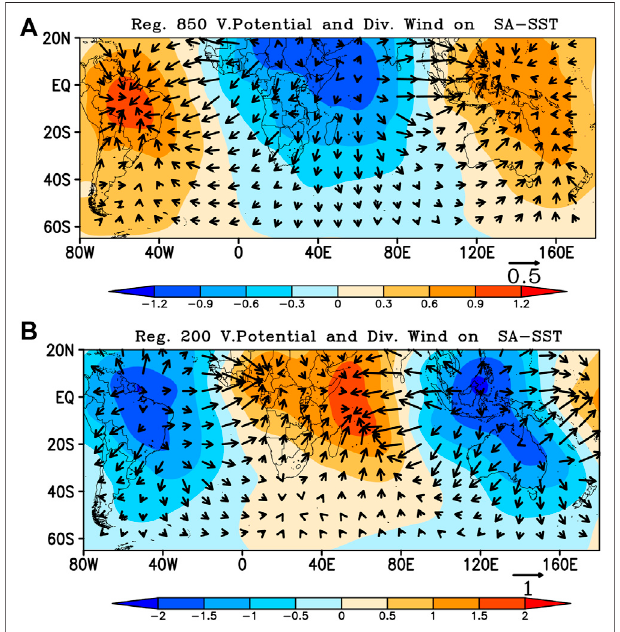
FIGURE 12 | Regressions of (A) 850 hPa velocity potential (shading; 10 6 m 2 s − 1 ) and divergent winds (vectors; m s − 1 ), (B) 200 hPa velocity potential (shading; 10 6 m 2 s − 1 ) and divergent winds (vectors; m s − 1 ), against the SA index during OND season for 1950 – 2017.